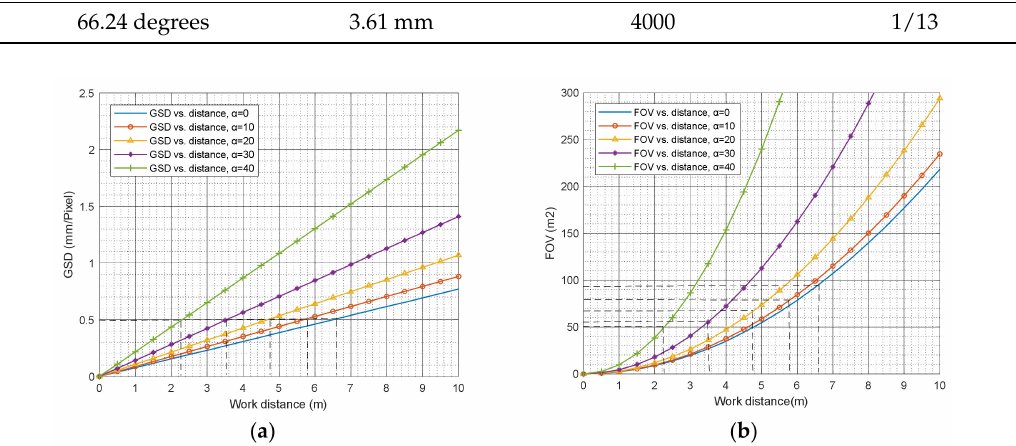
Figure 5. Correlation of ( a ) GSD and ( b ) FOV versus work